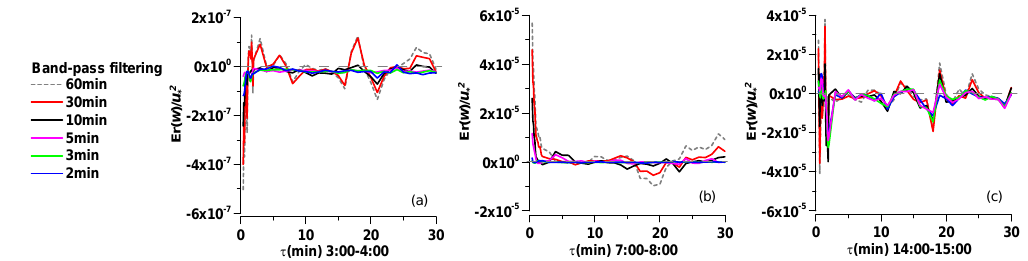
Figure 5. Variation of the autocorrelation ergodic function of vertical velocity with relaxation time for different scale eddies.